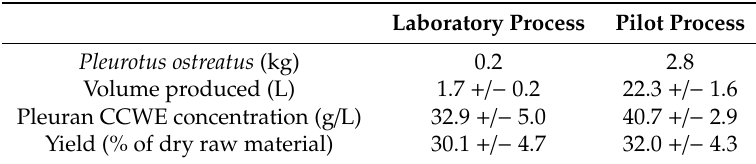
Table 1. Scaling-up from laboratory to pilot of Pleuran complex cell wall extract (CCWE) extraction process. Data are means +/ − standard deviation ( n = 23 for laboratory process; n = 12 for pilot